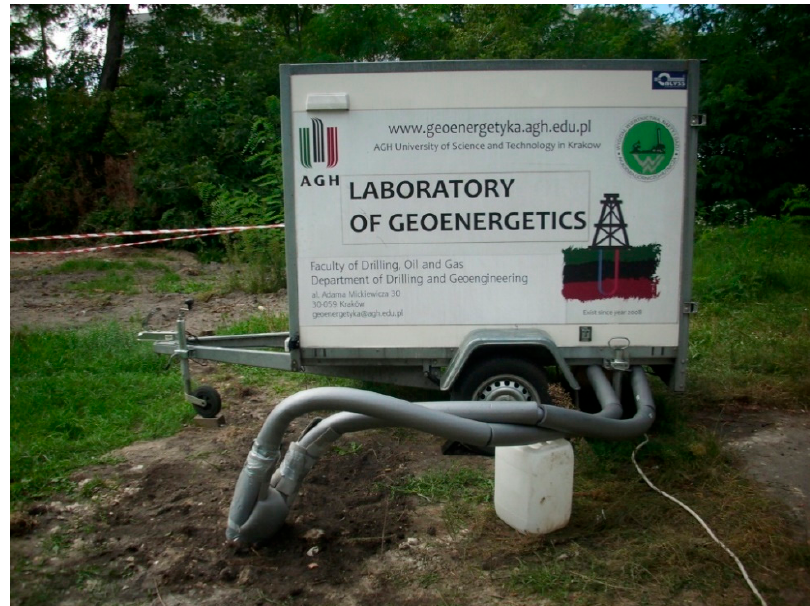
Figure 3. Thermal response test apparatus and its connection to the BHE.